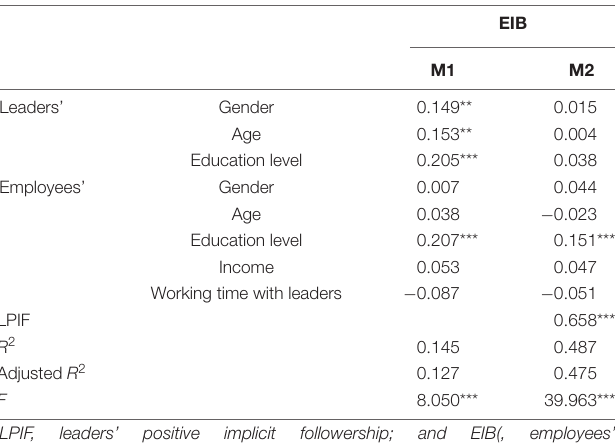
TABLE 3 | Main effects test.